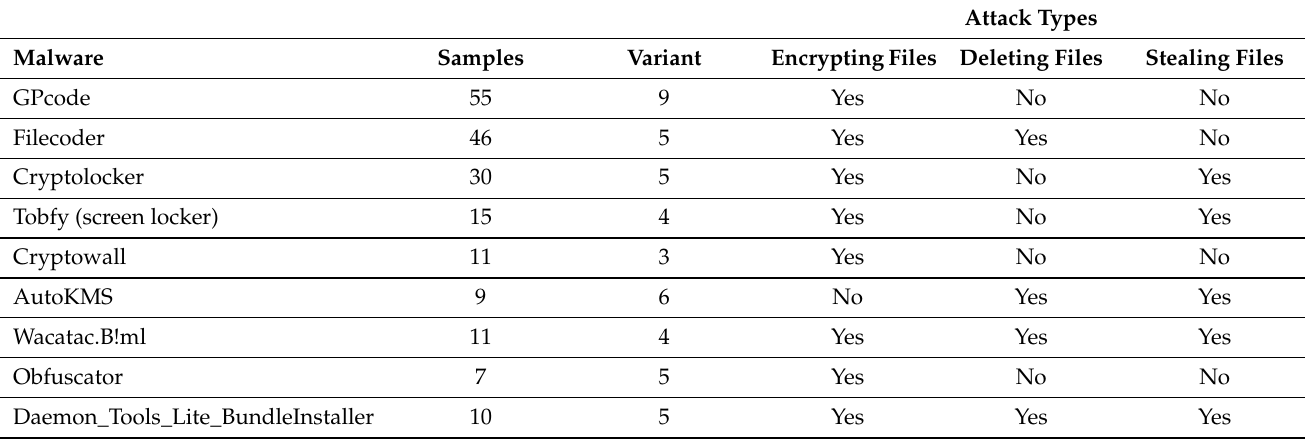
Table 3. Analyzed malware that was used in